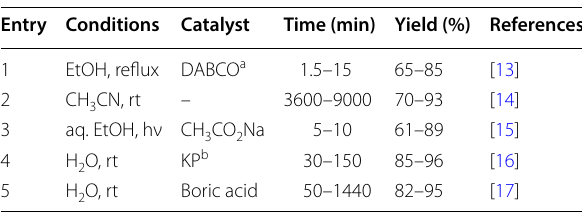
Table 3 Multicomponent synthesis